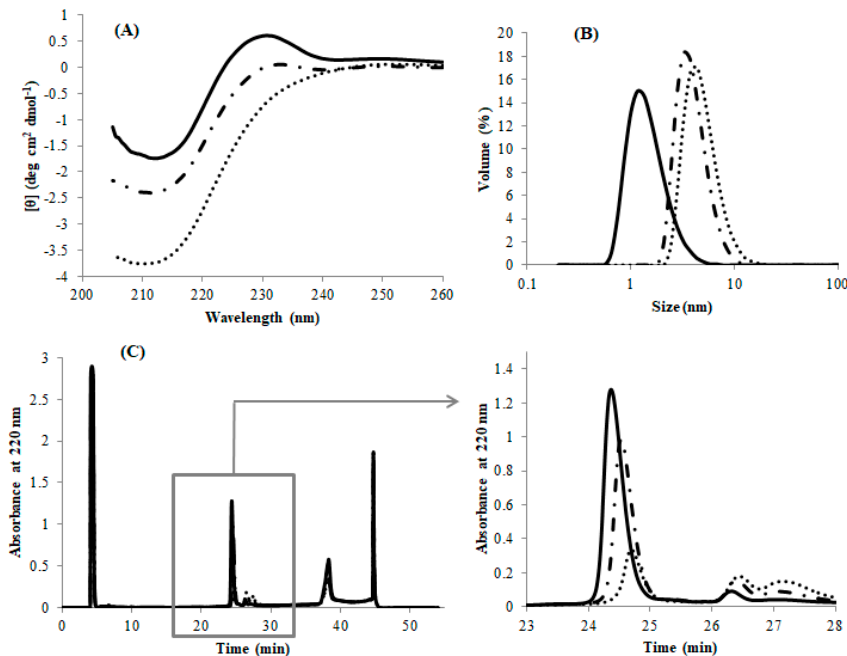
Figure 1. The physicochemical characterization of DEN4 ED3-1st sup (solid line); DEN4 ED3-2nd sup (dotted dashed line); DEN4 ED3-3rd sup (dotted line) at the protein concentration of 20 µM. (A) Circular dichroism (CD) spectra at pH 8 and 20°C. (B) Size-volume graphs measured by dynamic light scattering (DLS) at pH 8 and 20°C. (C) Reverse phase high performance liquid chromatography (RP-HPLC) chromatograms at pH 8 and 30°C. The flow rate was kept as 1 mL/min.